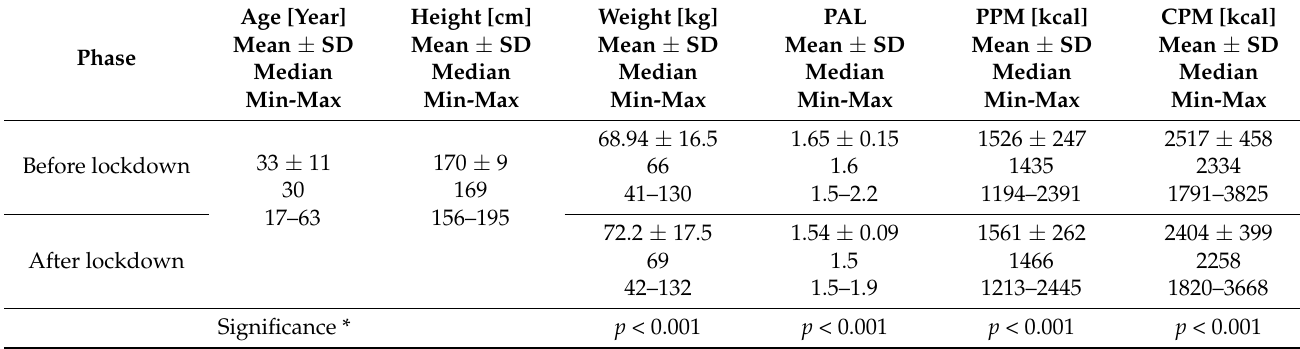
Table 2. Changes in body mass and energy needs of people who gained weight during the lockdown ( n = 90).